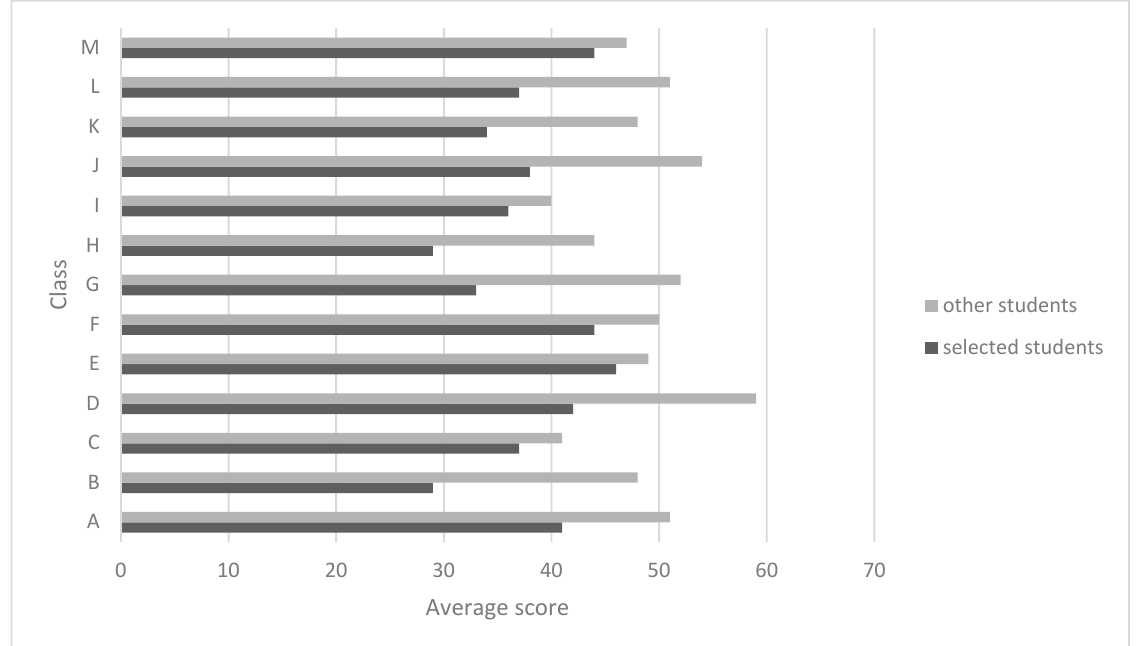
Figure 1. Average score according to the Talent Classification Sheet in thirteen classes.